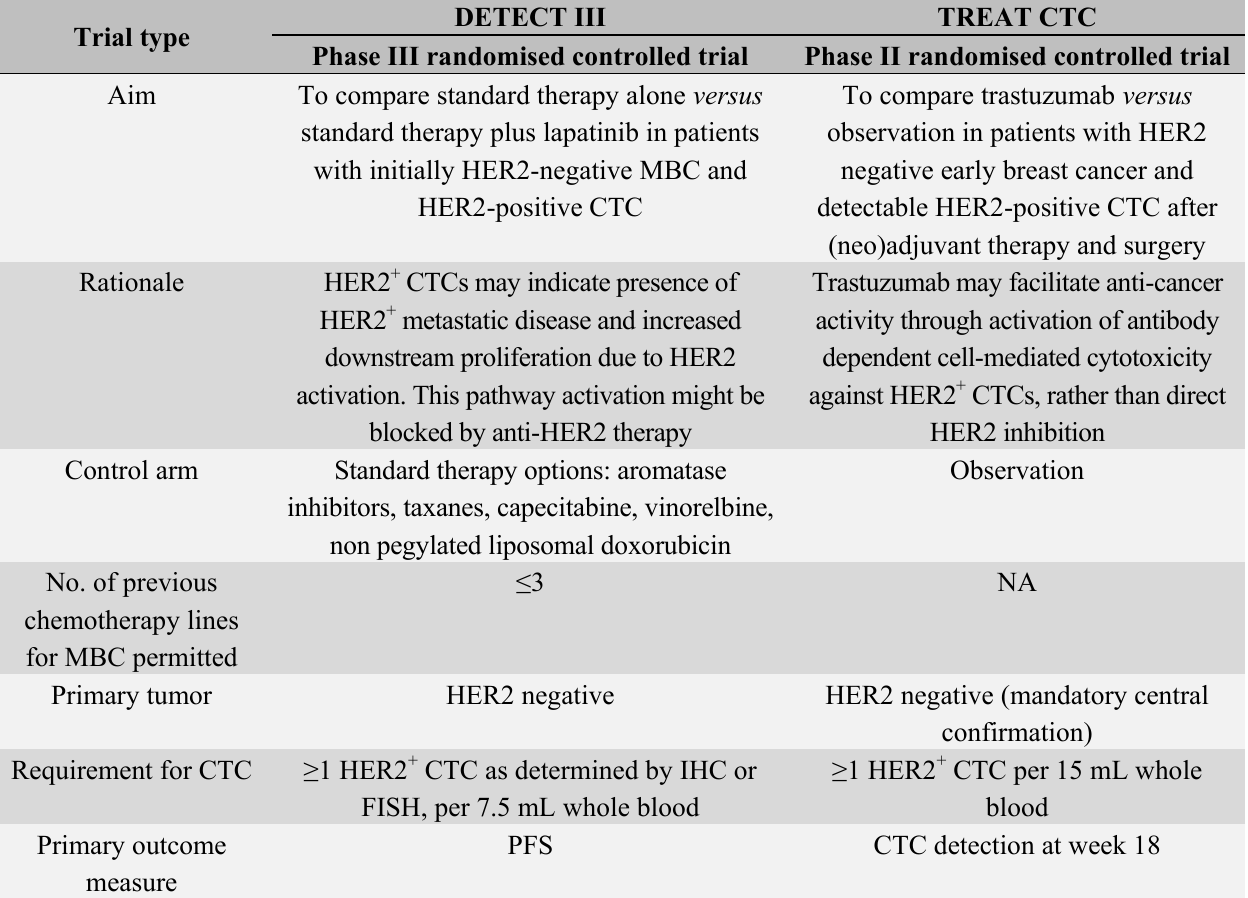
Table 3. Summary of DETECT III and TREAT CTC trial characteristics. CBR: clinical benefit rate; FISH: fluorescence in situ hybridisation; (I)DFS: (invasive) disease free survival; IHC: immunohistochemistry; MBC: metastatic breast cancer; NA: not applicable;